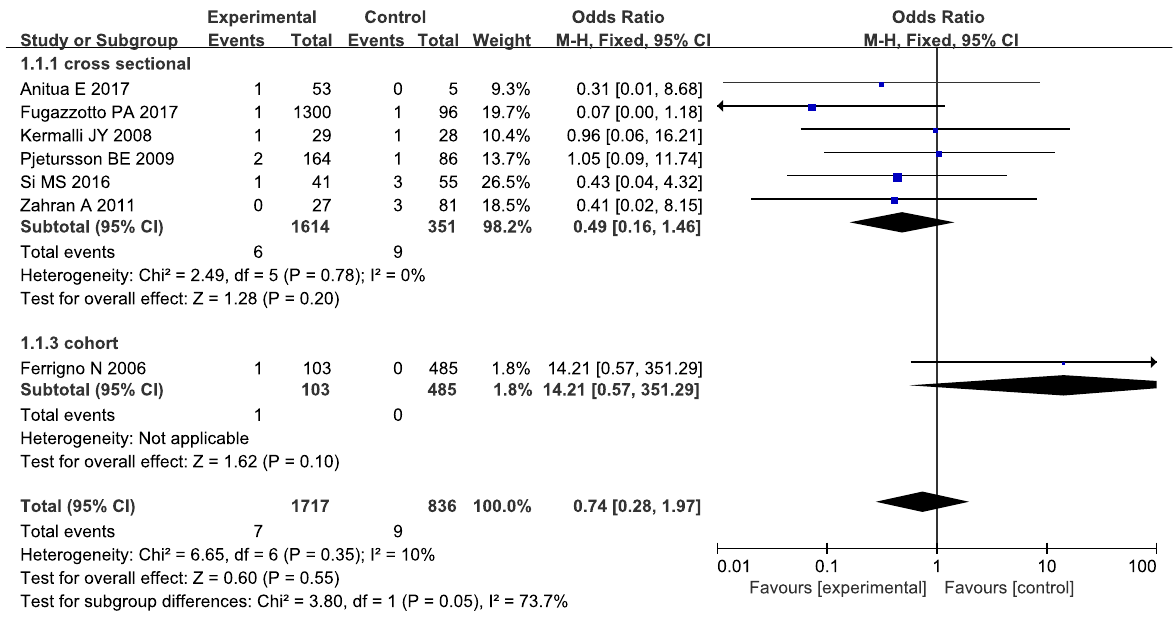
Fig. 2 Forest plot for the survival rate during the healing period between short implants combined with TSFE (experimental group) and conventional implants combined with TSFE (control group). TSFE, transcrestal sinus floor